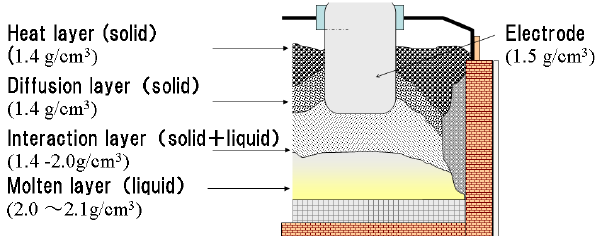
Fig. 2. Reaction model of a electric carbide furnace.